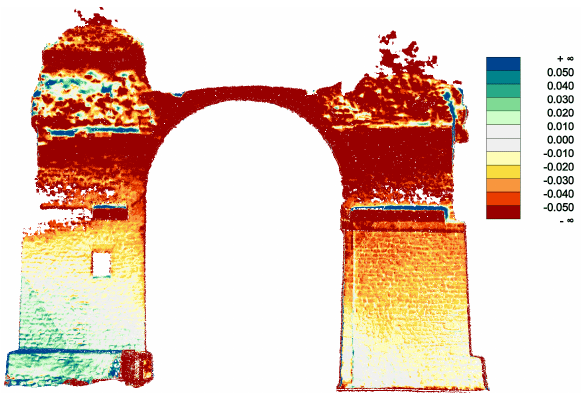
Figure 7: Visualisation of the difference model (units: meter) between the LS and the SfM surface model.